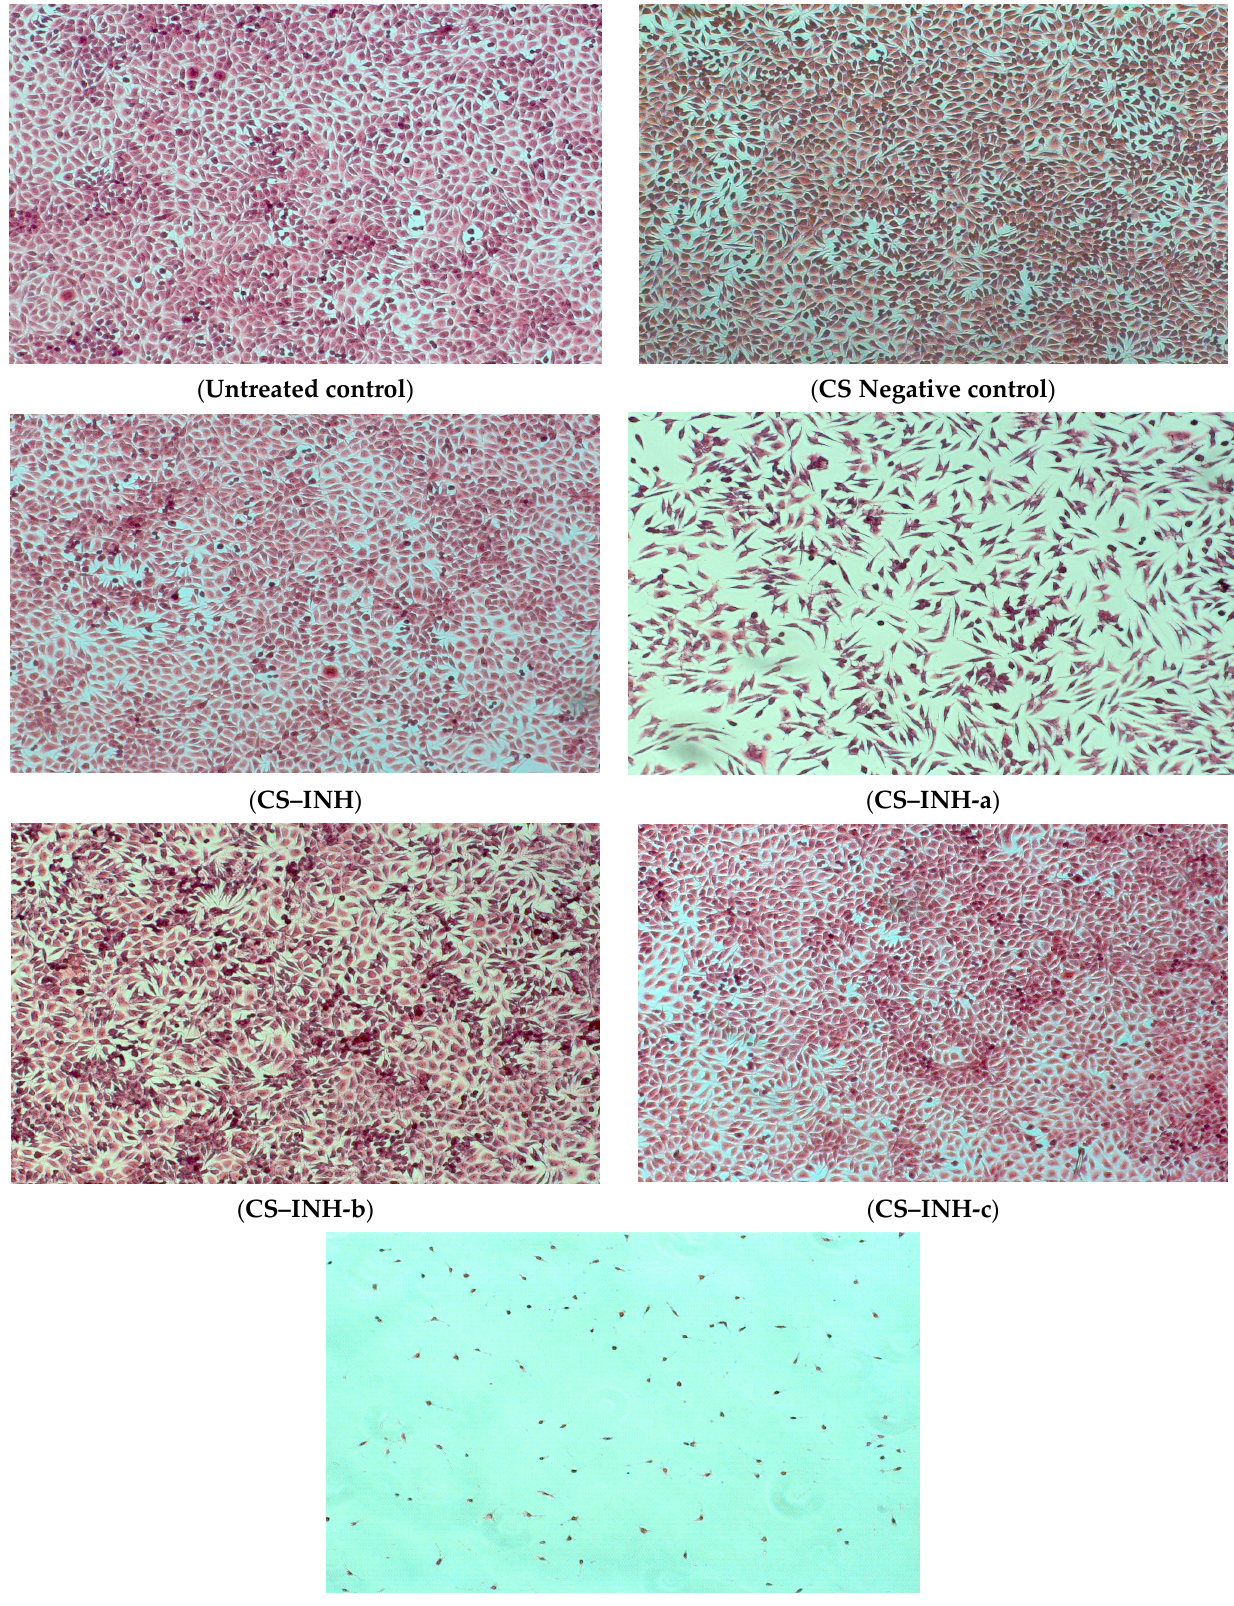
Figure 7. Cell morphology stained with hematoxylin–eosin after 72 h of incubation with microparticles of CS–INH derivatives, CS and CS–INH negative controls.